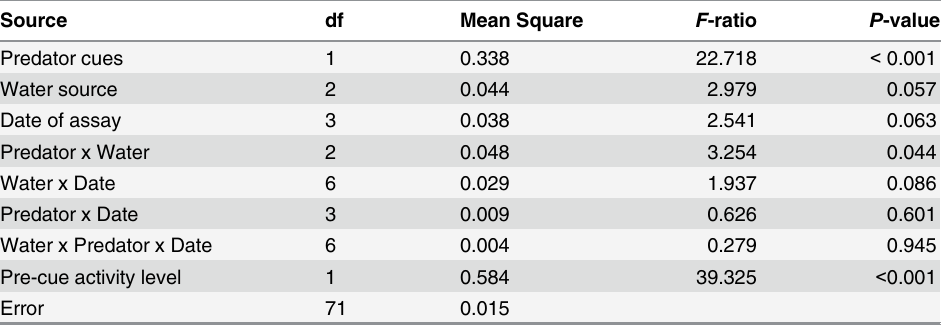
Table 2. Analysis of variance testing overall effects of predator cues, water source, and date of assay on activity of gray treefrog tadpoles. Source